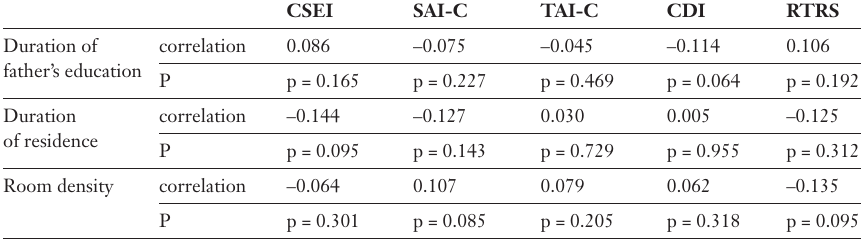
Table 3. Correlation of the psychometric tests (CSEI, SAI-C, TAI-C, CDI, RTRS) with age of the child, duration of the father’s educa- tion, duration of resi- dence after migration and room density in migration